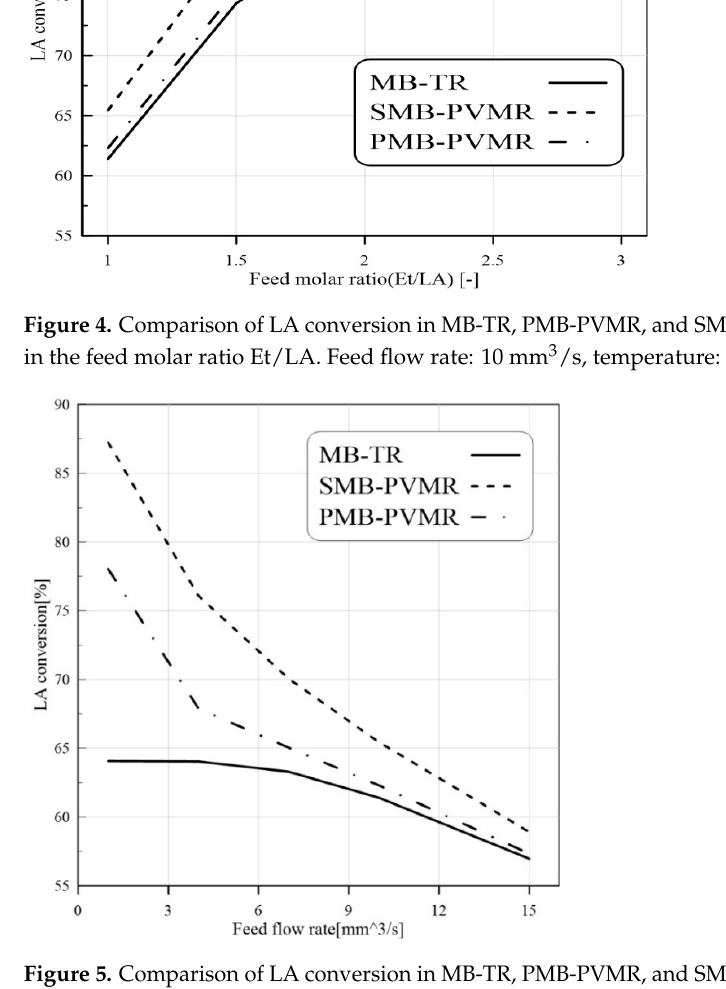
Membranes 2022 , 12 , 1000 9 of 13